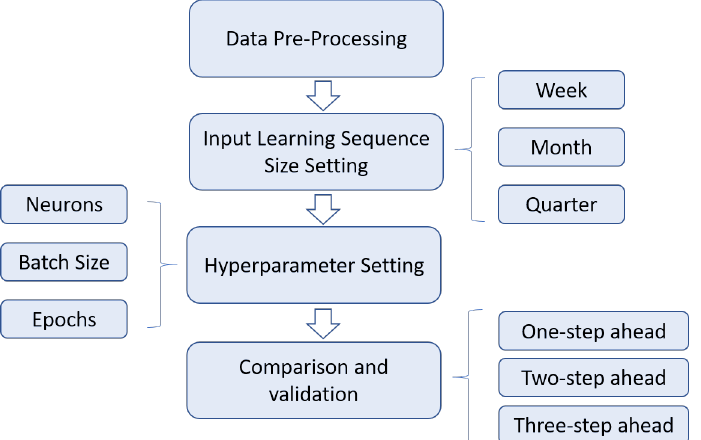
Figure 8. Implementation process of the different DL models, for one-step and three-steps ahead